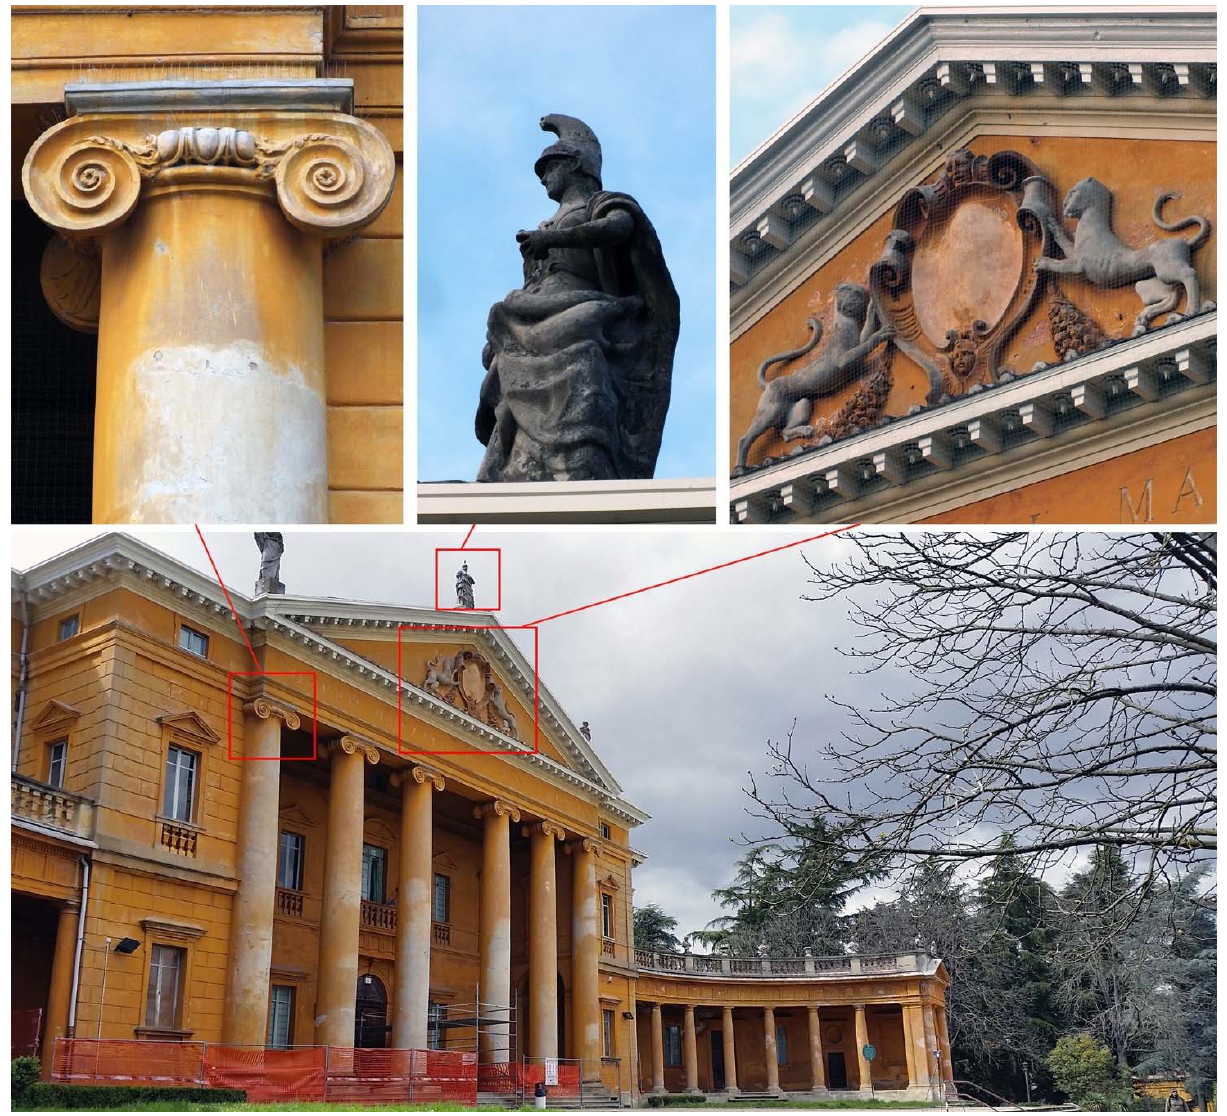
Figure 1. Pictures of the main façade of Villa Aldrovandi Mazzacorati and some architectonic and sculptural details.